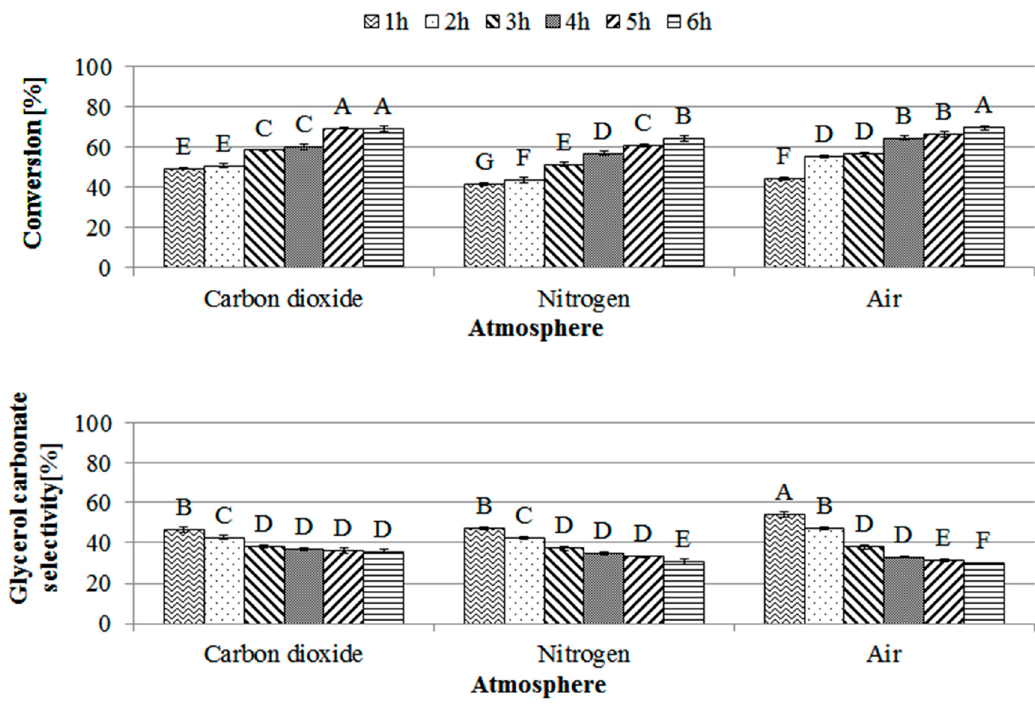
Figure 7. The influence of atmosphere on the catalytic performance of a biosolids-based catalyst. The following reaction conditions were used: A catalyst:glycerol ratio of 9 wt %, a temperature of 140 °C, a 2:1 molar ratio of urea:glycerol, and three different gas streams to remove NH 3 formed during the reaction (air, N 2 , CO 2 ). The errors represent the standard deviations calculated according to the values of three experiments. The means of triplicate experiments are reported, with the error bars representing standard deviation. Data annotated with different letters are significantly different (confidence level of 95%).